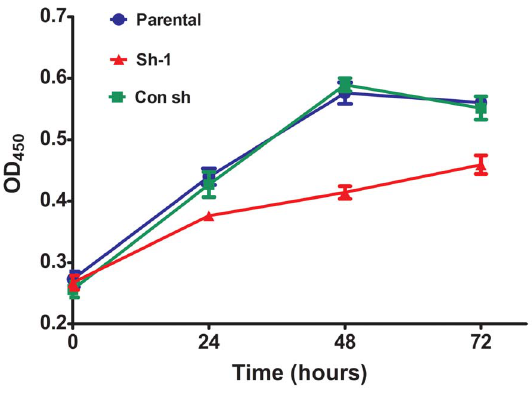
Figure 5. Prx-I knockdown inhibited the proliferation of T24 cells in vitro. The growth rates in Prx-I knockdown group was significantly reduced, compared with the parental and con sh groups, measured by CCK8 assay.